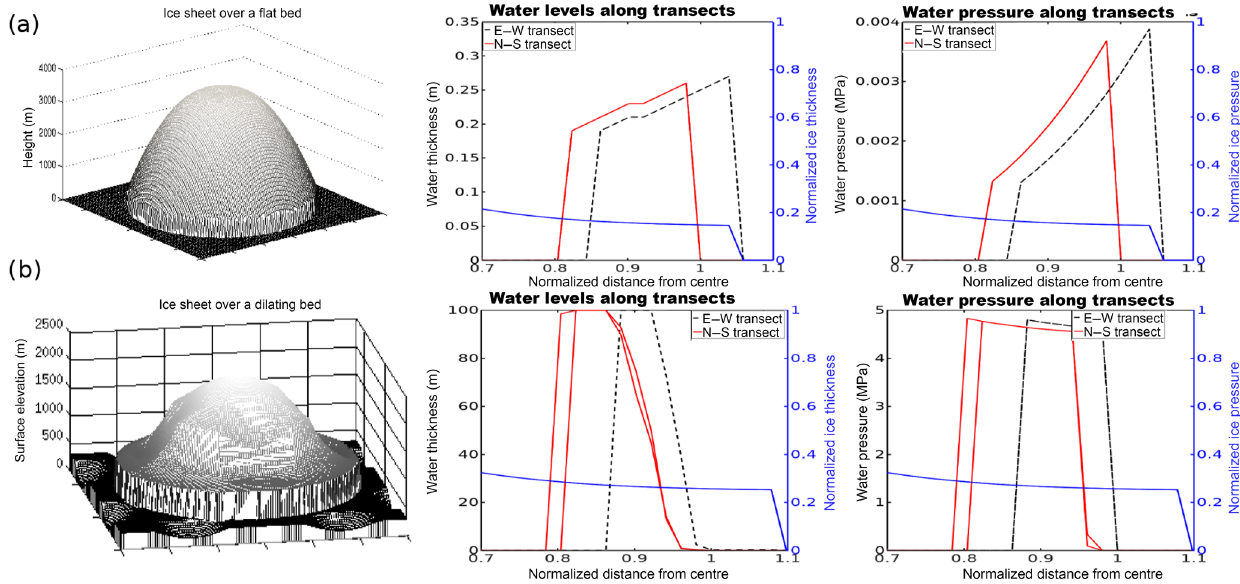
Figure 1. Simple synthetic ice sheet testing scenarios. Transects are plotted as the absolute, normalized distance from the centre. (a) A dome-shaped ice sheet placed on a flat bed resulting in symmetric results. (b) The ice dome on a dilating bed. Lake formation occurs where the ice sheet is relatively flat and the topography dips.